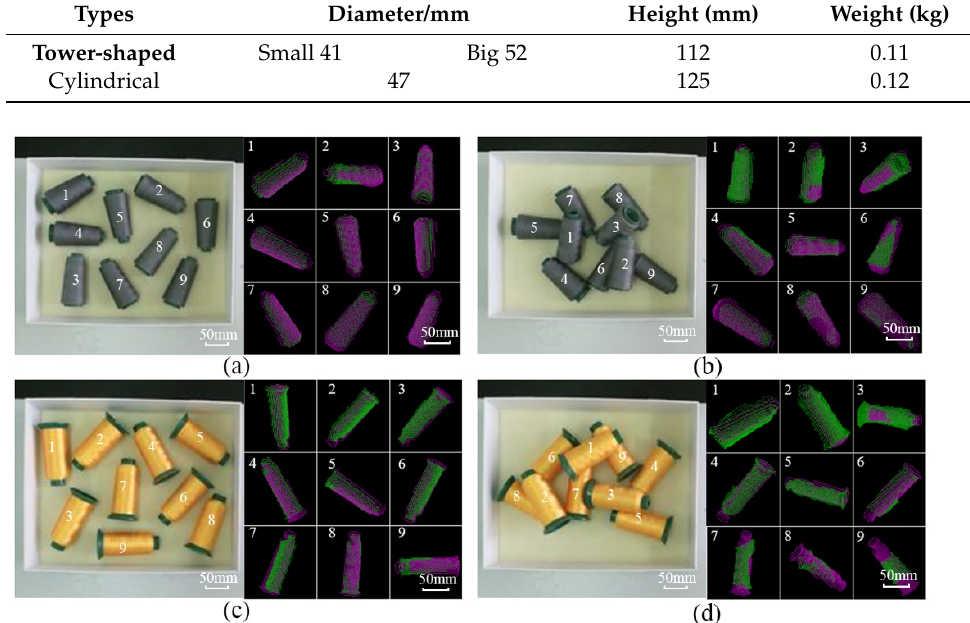
Figure 9. Experimental tests in different scenarios: ( a ) Tower yarn bobbin without contact scenario; ( b ) Tower yarn-bobbin stacking scenario; ( c ) Cylindrical yarn bobbin without contact scenario; ( d ) Cylindrical yarn-bobbin stacking scenario.